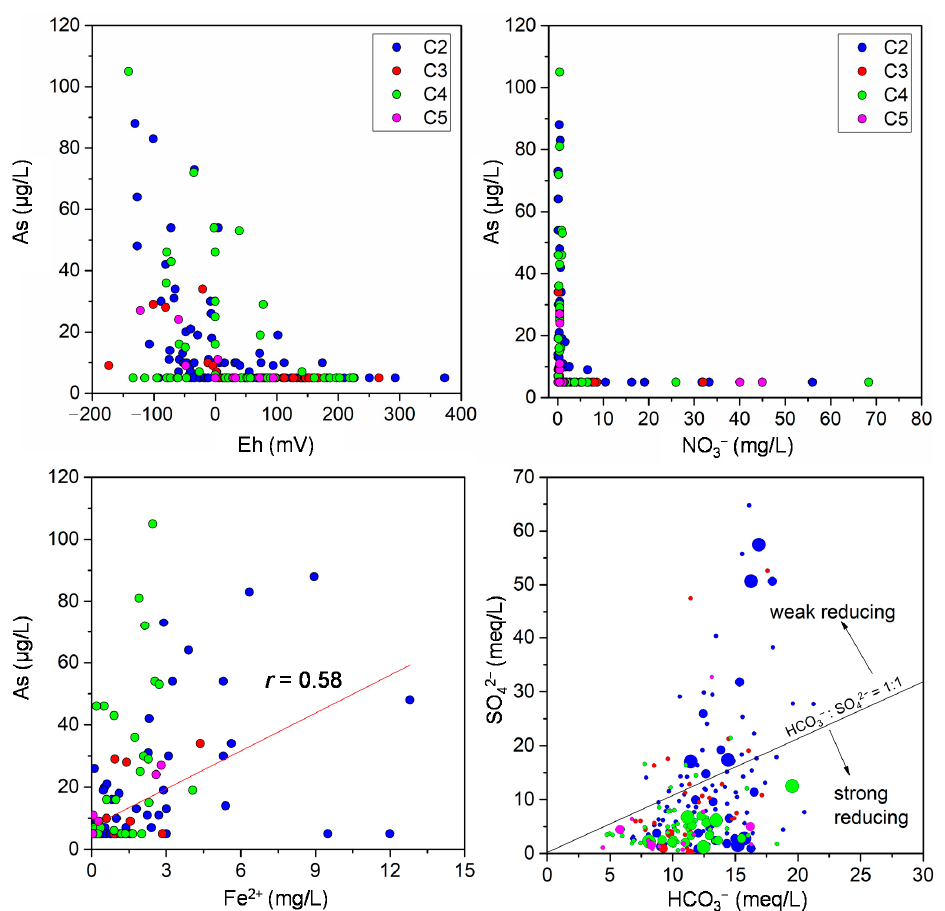
Figure 7. Scatter plot of As versus Eh; NO 3 − ; and Fe 2+ ; bubble diagram of SO 42 − versus HCO 3 − in groundwater with different As concentrations.